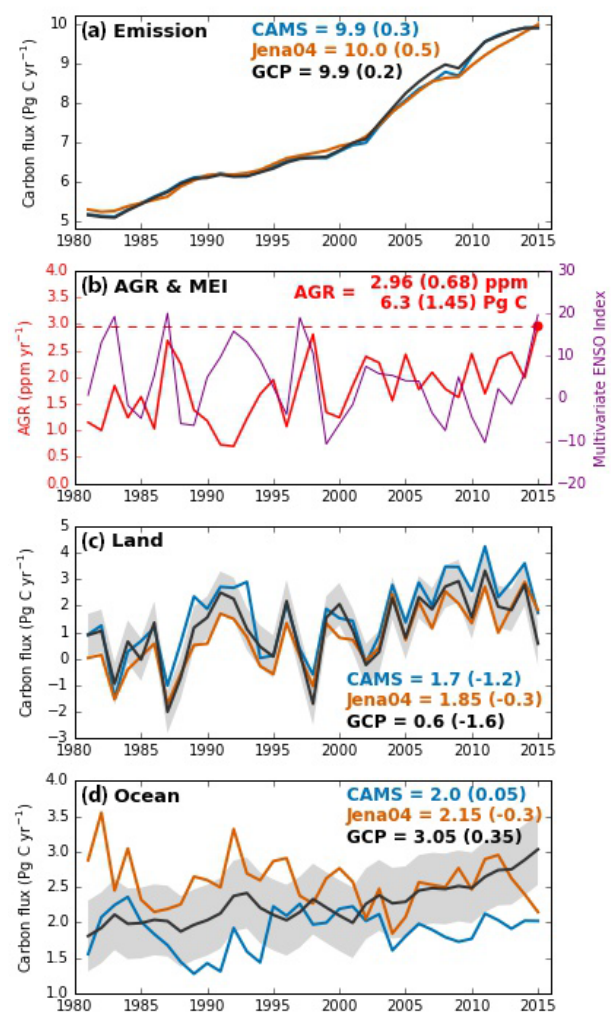
Figure 2. Global carbon fluxes and atmospheric CO 2 growth rates for 1981–2015. (a) Carbon emissions from fossil fuel and industry used in the CAMS (blue) and Jena04 (orange) inversions, (b) annual atmospheric CO 2 growth rate (AGR, in red) from NOAA/ESRL linked to Multivariate ENSO Index (MEI, in purple), (c) land and (d) ocean carbon sinks for 1981–2015. Emissions, land and ocean carbon sinks from the Global Carbon Project (GCP, in black) are also shown for comparison. In panels (c) and (d) , a carbon flux of 0.45Pg Cyr − 1 was used to correct inversion-derived land and ocean sinks to account for preindustrial land-to-ocean carbon flux as in Le Quéré et al. (2016). All numbers indicate values in 2015 (Pg Cyr − 1 , rounded to ± 0.05Pg Cyr − 1 ) , with those in brackets showing linearly detrended anomalies for the same